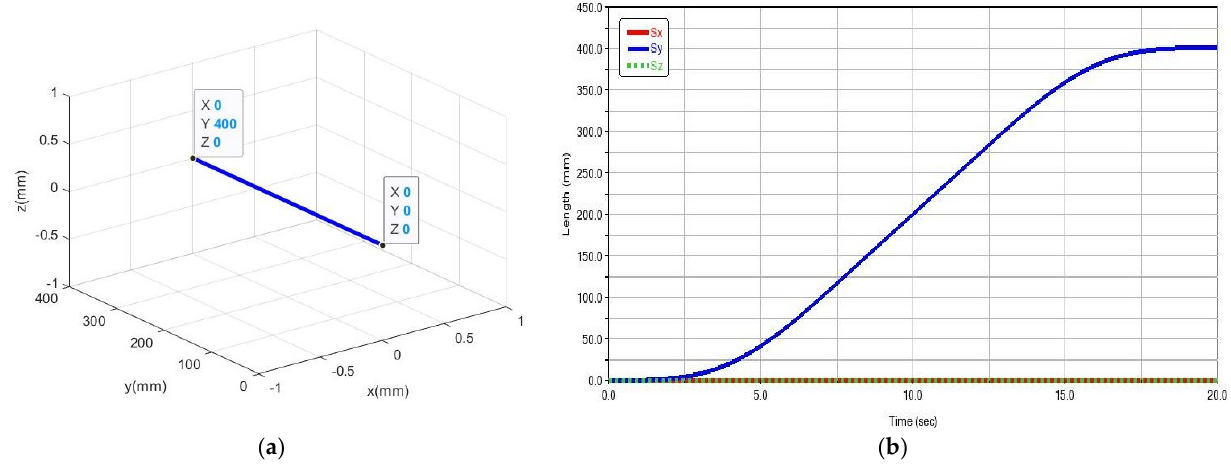
Figure 13. The motion parameter curves of the chassis straight motion. ( a ) Trajectory curve; ( b ) dis- placement curve.